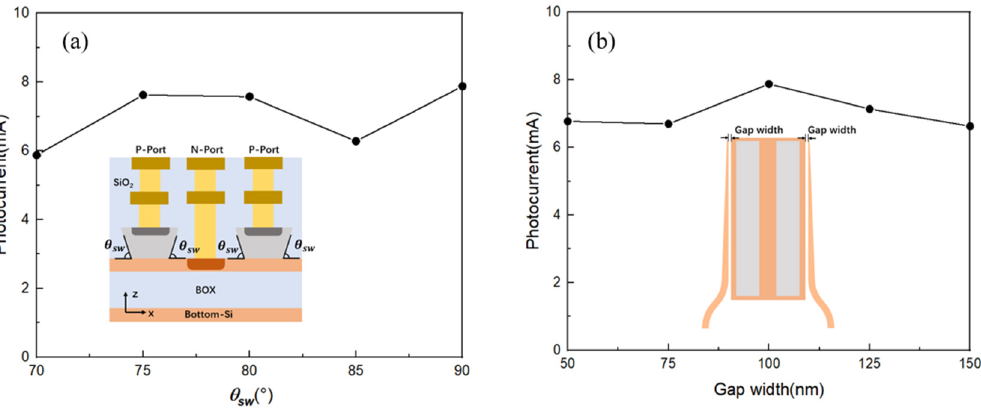
Figure 4. The simulated photocurrent as a function of ( a ) sidewall angle and ( b ) gap width; the input power is set to 10 mW at 1550 nm wavelength, and the bias voltage is − 1 V.